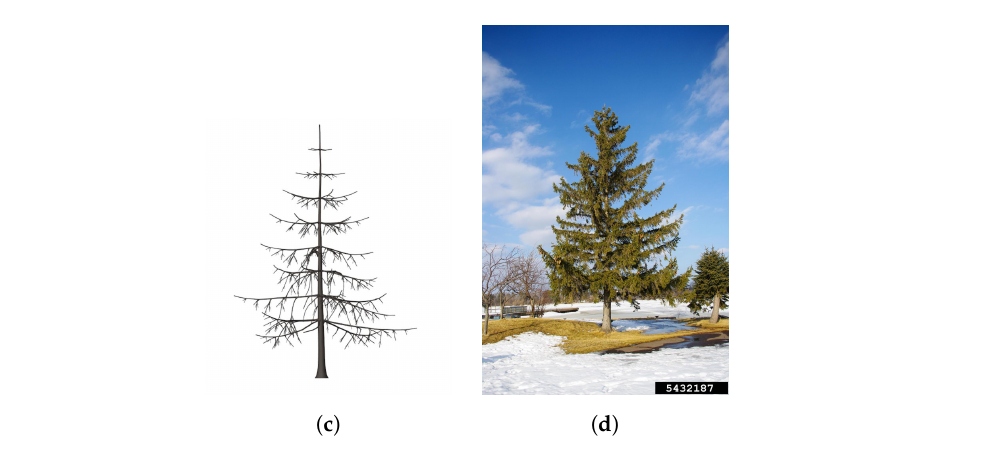
Figure 18. Visual comparison for different shape trees. ( a , b ) are columnar shaped trees; ( c , d ) are conical shaped trees. ( a ) Columnar shaped tree with branching angle equal to 45° and number of children set equal to 2; ( b ) Real photo of a Populus nigra for comparison. Photo courtesy of T. Davis Sydnor, The Ohio State University, Bugwood.org; ( c ) Conical shaped tree with branching angle of 90° for the primary branches, 55° for the secondary and tertiary branches and number of children equal to 5; ( d ) Real photo of a Picea abies for comparison. Photo courtesy of Judy Slater,